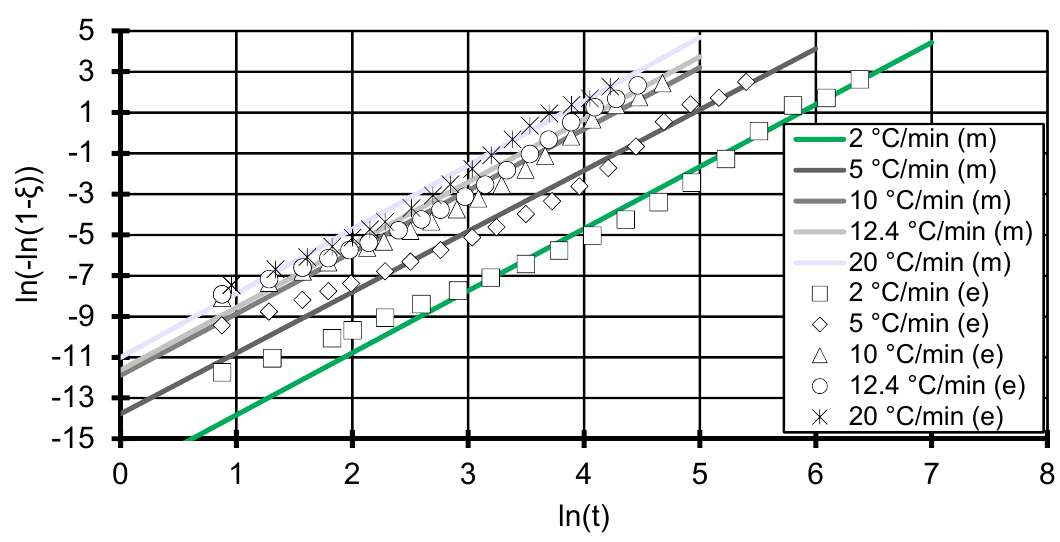
Figure 2. Avrami plot of 5 cooling rates from 2 to 20 °C/min. The markers show the experimental (e) data taken by the differential scanning calorimeter DSC Q2000, TA Instruments, New Castle, Delaware, USA. Lines represent the modelled (m) Avrami relation for each cooling rate. The experimental data were reduced to 20 points to ensure clarity of the figure.